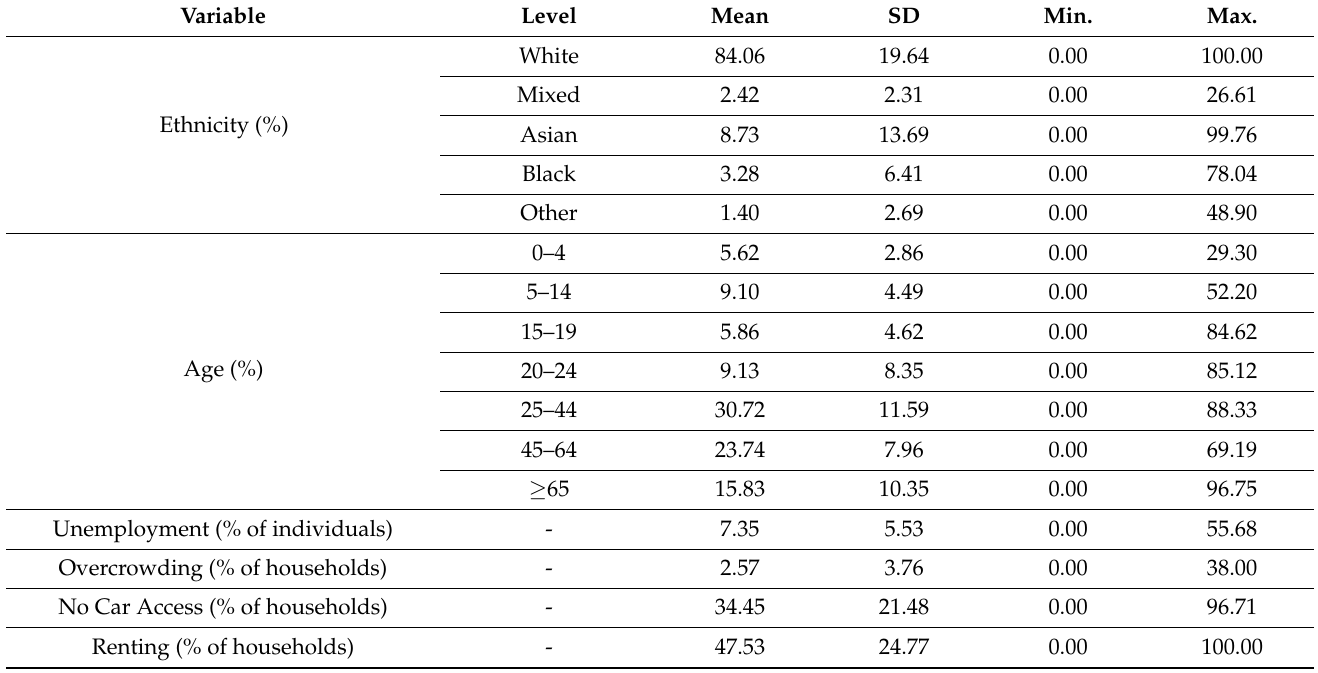
Table 2. Descriptive statistics for numerical predictor variables. All variables are reported at output area level (SD = Standard